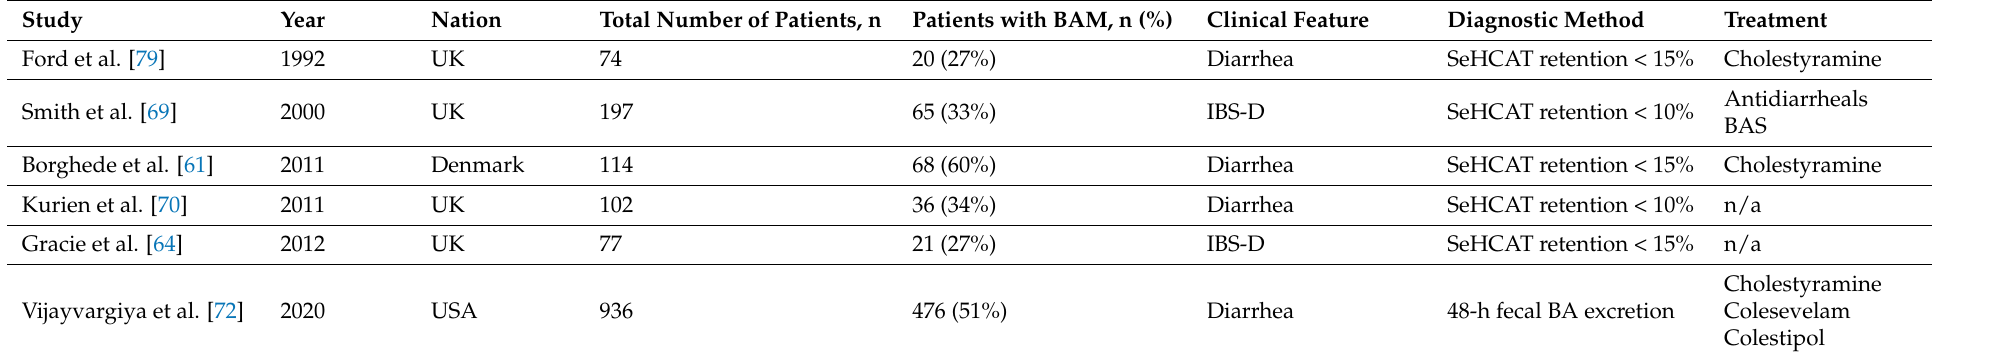
Table 2. Studies investigating the prevalence of bile acid malabsorption type